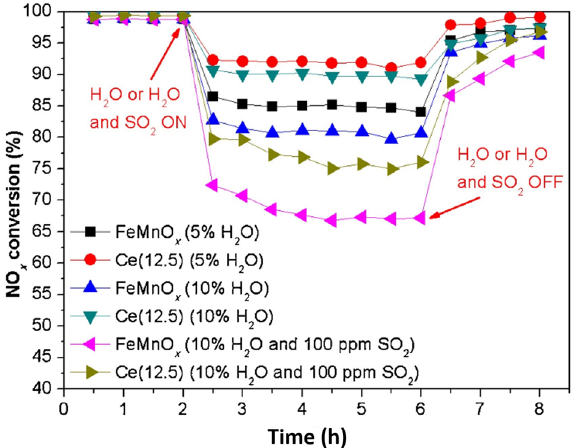
Figure 13. The effects of SO 2 and H 2 O on the SCR activities of MnO x (0.4)–CeO 2 (500) ‐ based catalysts (Reaction conditions: 0.2 g catalyst, [NH 3 ] = [NO] = 1000 ppm, [O 2 ] = 2%, He = balance and total flow rate = 100 mL / min, T = 150 °C). (Reproduced with permission from Reference [35], Copyright 2004, Elsevier.).